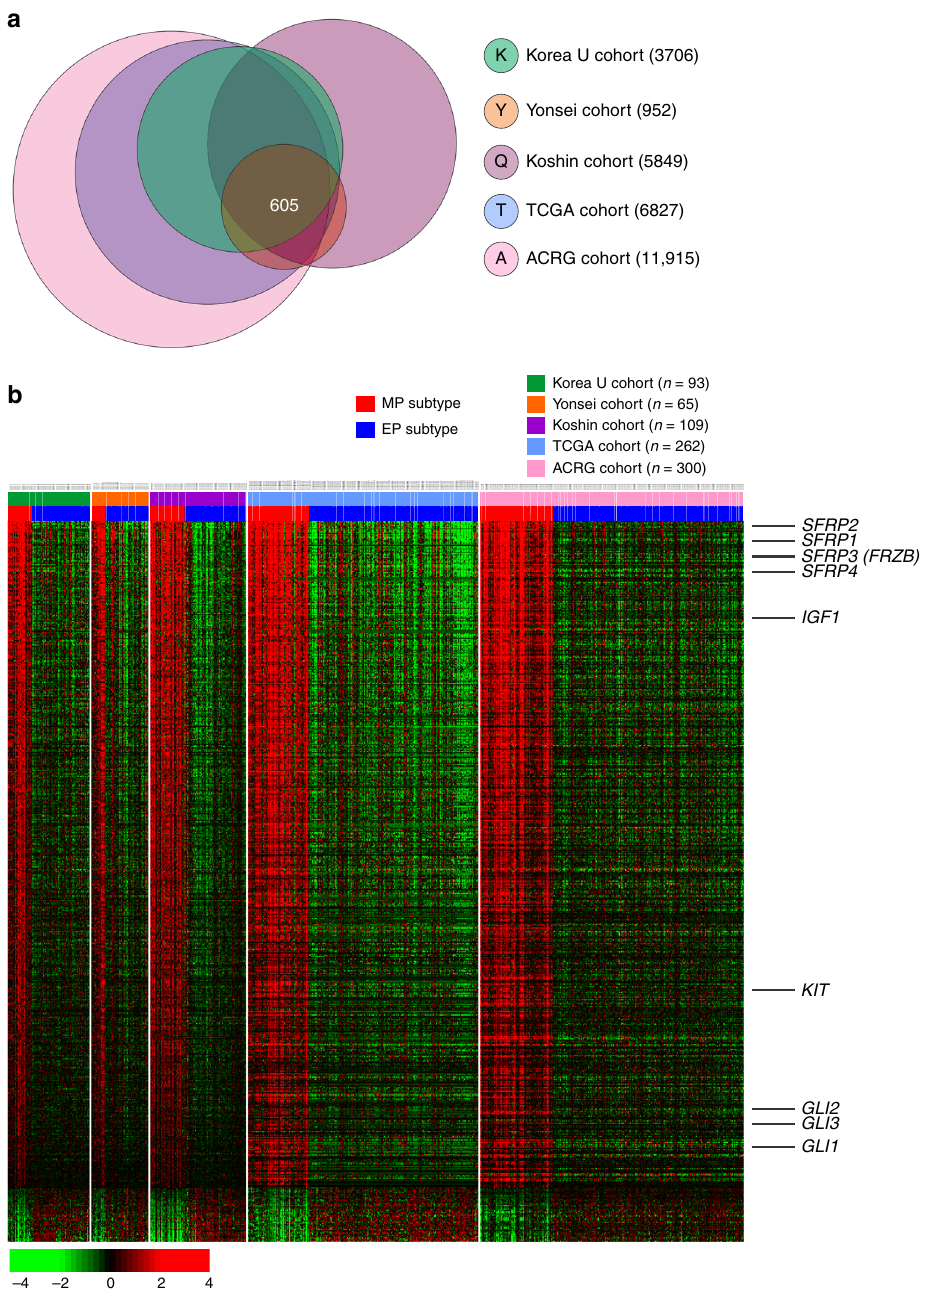
Fig. 6 Subtype-speci fi c gene expression patterns conserved in fi ve cohorts of patients with gastric cancer. a Venn diagram of genes with expression that differed signi fi cantly between the mesenchymal phenotype (MP) and epithelial phenotype (EP) subtypes in fi ve different cohorts (KUCM Kosin University College of Medicine, KUGH Korea University Guro Hospital, TCGA The Cancer Genome Atlas, YUSH Yonsei University Severance Hospital, ACRG Asian Cancer Research Group). Gene expression differences were considered statistically signi fi cant at P < 0.001 by Student ’ s t -test. This stringent signi fi cance threshold was used to limit the number of false-positive fi ndings. Expression of only 605 genes was upregulated or downregulated in all fi ve cohorts. b Expression patterns of selected genes. The colored bars at the top of the heat map represent samples as